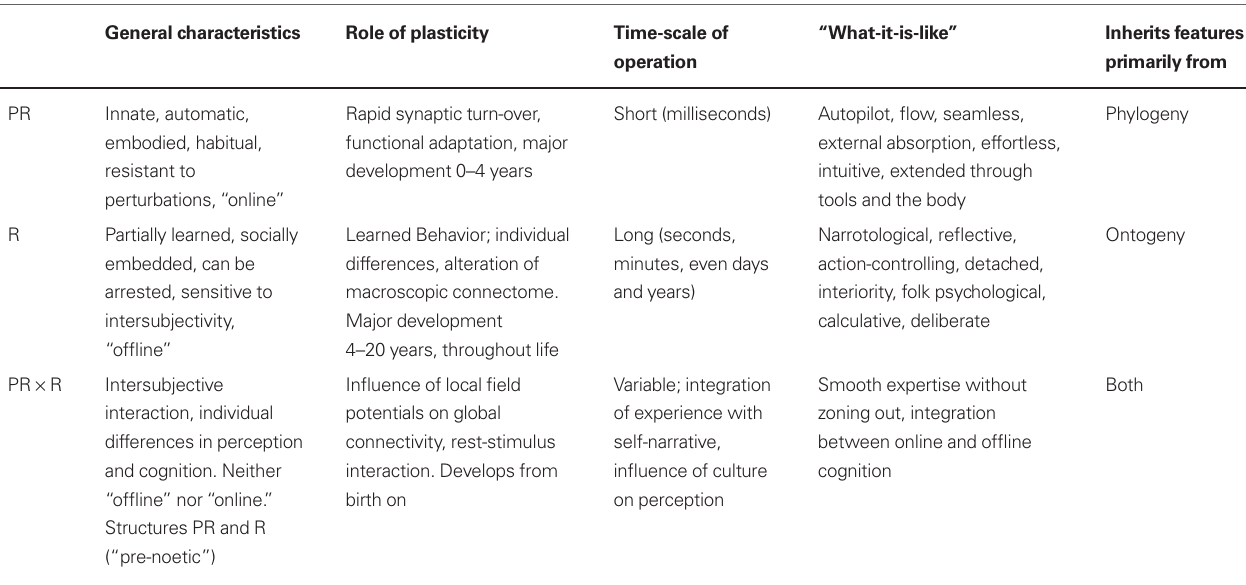
Table 1 | Qualitative differences between prereflective and reflective consciousness, and their interaction. General